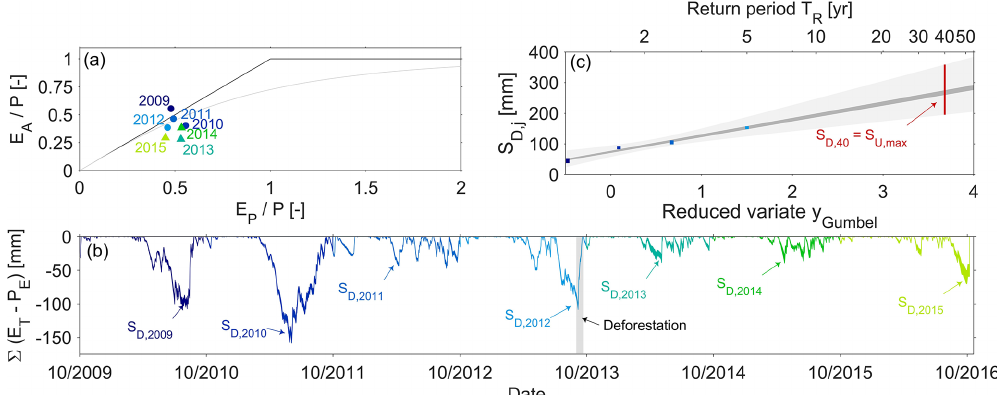
Figure 5. (a) Positions of the individual years of the study period in the Budyko framework. The x axis shows the aridity index I A = E P /P ; the y axis indicates the evaporative ratio E A /P and the runoff ratio C R = 1 − E A /P . Pre-deforestation years are shown with blueish shades, post-deforestation years with greenish shades. The bold black lines indicate the energy and water limits, respectively. The dashed grey line is the theoretical–analytical Turc–Mezentsev relationship (Turc, 1954; Mezentsev, 1955). (b) The range of time series of storage deficits as computed according to Eq. (2), using values of I max from 0 to 4mm. The maximum annual storage deficits S D ,j are indicated by the arrows. The grey shaded area indicates the deforestation period. (c) Estimation of S U,max as the storage deficit associated with a 40-year return period S D , 40yr using the Gumbel extreme value distribution for the pre-deforestation period. The blueish dots indicate the range of maximum annual storage deficits S D ,j for each year in the 4-year pre-deforestation period. The dark-grey shaded area indicates the envelope of least-square fits for the individual values of I max . The light-grey shaded area indicates the envelope of the 5th / 95th confidence intervals. The red line shows the plausible range for S U,max